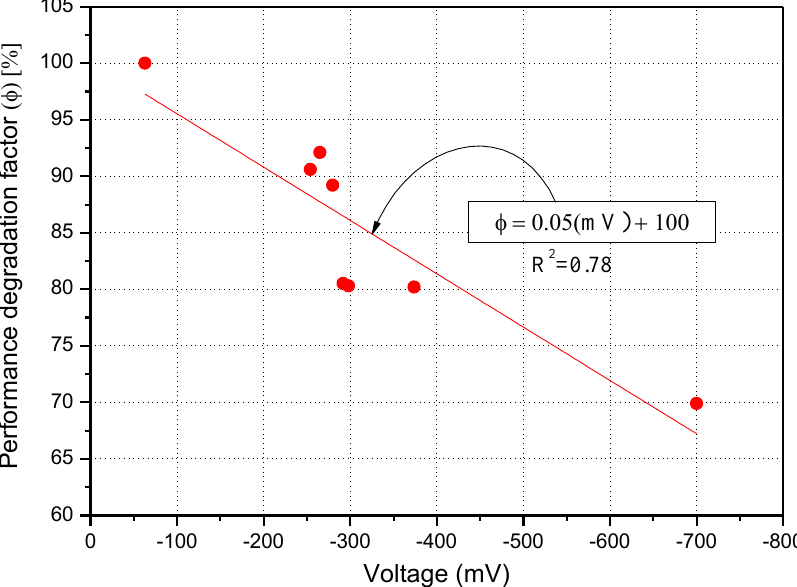
Figure 15. Relationship between average potential difference in terms of voltage (mV) and perfor- mance reduction factor ( ϕ ) of flexural beam specimens (Test).